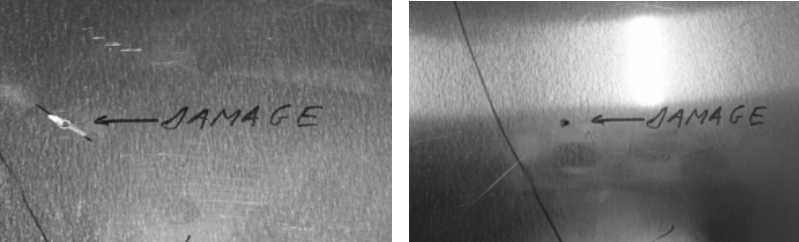
Fig. 13. Example of two types of damages created in the plate.